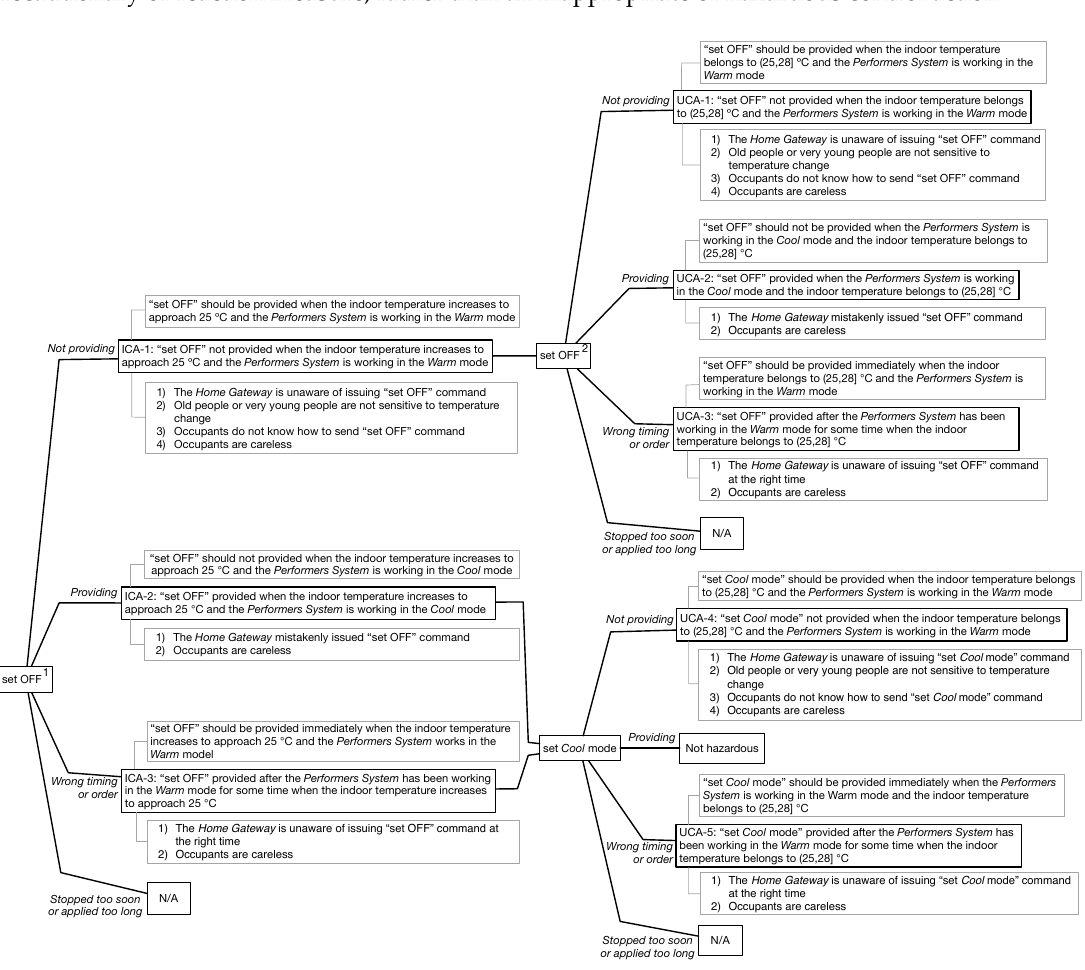
Figure 8. The analysis results for the control action “set